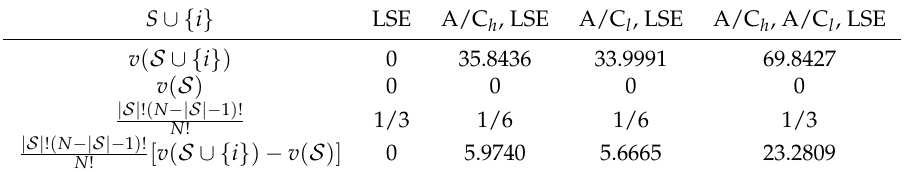
Table 8. Reward of